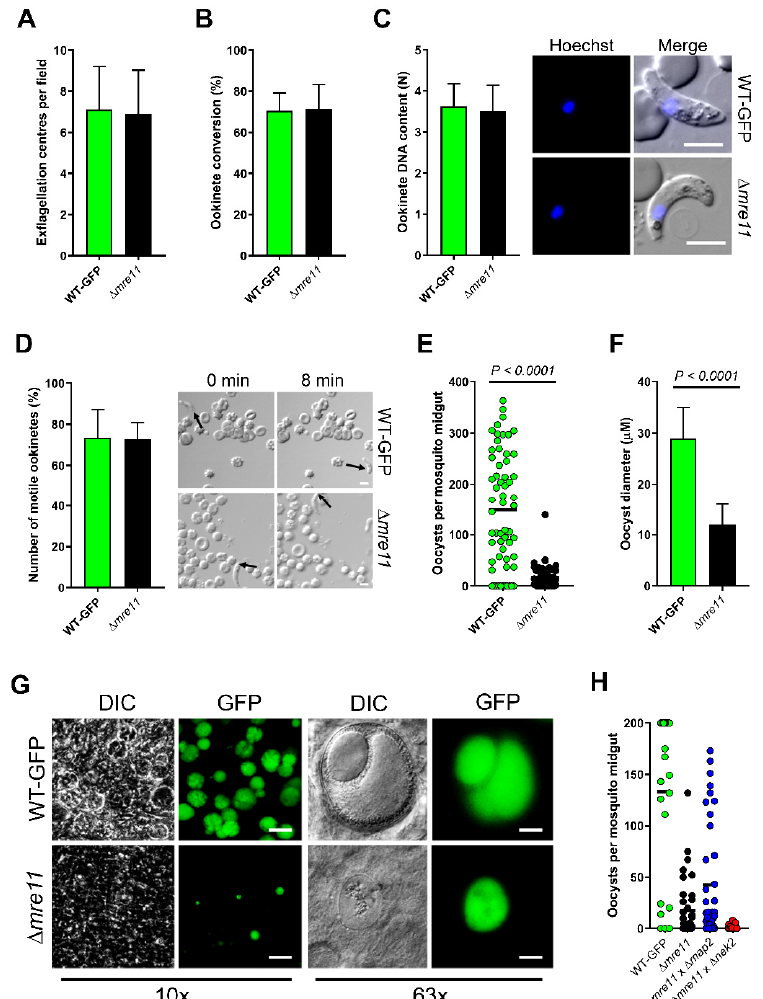
Figure 2. PbMRE11 is dispensable in the asexual and the sexual stages but important for oocyst development and sporogony. ( A ) Microgametogenesis of ∆ mre11 lines compared with WT-GFP controls measured as the number of exflagellation centres per field. Means ± SEM are shown. n = 20 from 3 independent experiments. ( B ) Ookinete conversion as a percentage in ∆ mre11 and WT-GFP lines. Ookinetes were identified using the marker P28 and defined as those cells that successfully di ff erentiated into elongated ‘banana shaped’, stage 6 ookinetes. Bar is the mean ± SEM. n = 3 independent experiments, with > 200 cells counted in each. ( C ) DNA content of mature ookinetes. Bar is the mean ± SD. n = 36 each for WT-GFP and ∆ mre11 lines. Bar = 5 µ m. ( D ) Representative frames from time-lapse movies of WT (upper panels) and ∆ mre11 (lower panels) ookinetes in Matrigel. Arrow indicates the apical end of the ookinete. Bar = 10 µ m. A number of individual WT or ∆ mre11 ookinetes from 24 hr cultures was measured over 8 min. Bar is the mean ± SEM; n = 3 biological replicates with 3 ookinetes measured in each as technical replicates. ( E ) Total number of GFP-positive oocysts per infected mosquito, at 14 dpi for ∆ mre11 and WT-GFP lines. Bar = arithmetic mean. n = 3 independent experiments (20 mosquitoes for each). ( F ) Comparison of oocyst size in ∆ mre11 and WT-GFP lines at 14 dpi. Bar is the mean ± SEM. n = 200 oocysts. ( G ) Example of relative oocyst size and numbers at 10 × and 63 × magnification in ∆ mre11 and WT-GFP lines. Images show DIC, Hoechst and GFP at 14 dpi. Scale bar = 50 µ m for 10 × and 10 µ m for 63 × . ( H ) Genetic complementation of ∆ mre11 . Mosquitoes were fed with a combination of WT-GFP, ∆ mre11 or ∆ mre11 with either male ( ∆ map2 ) or female ( ∆ nek2 ) mutants. Shown is a representation of three independent experiments (at least 10 mosquitoes per line, per